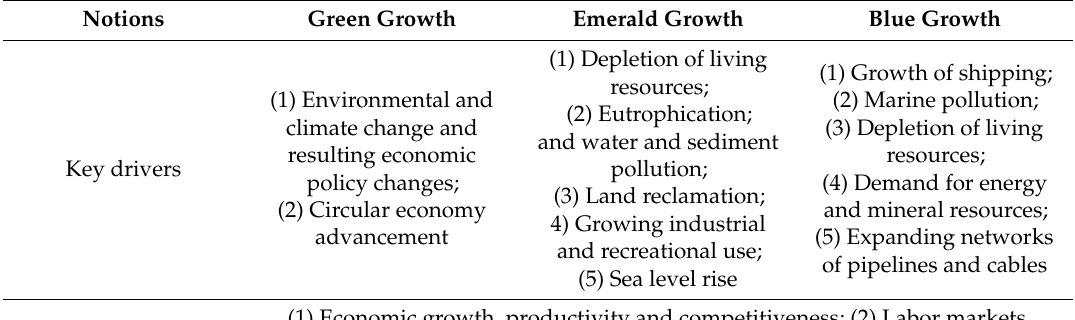
Table 2. Drivers, indicators and planning approaches relevant in the spatial planning